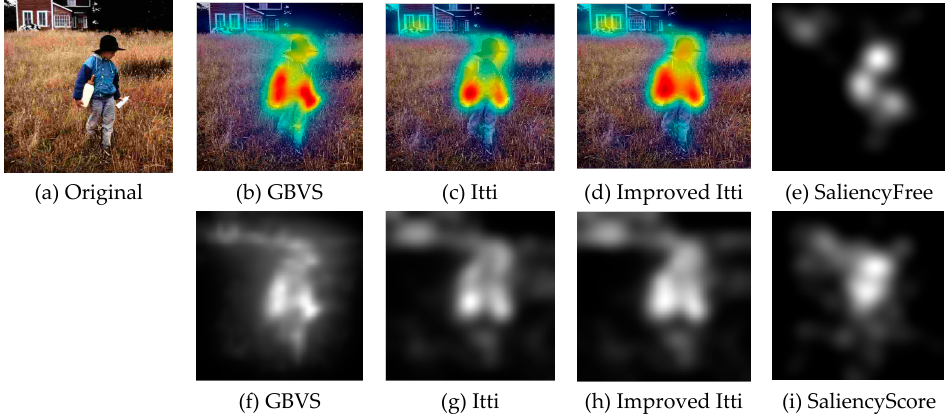
Figure 12. Comparison of different visual saliency models. ( a ) Original image; ( b – d ) salient overlap